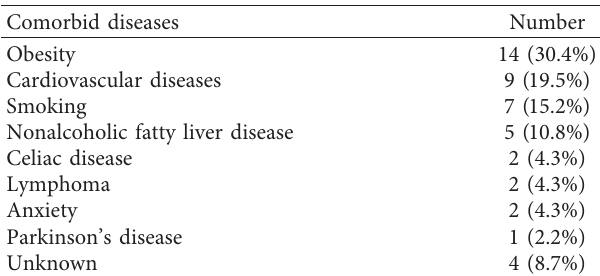
Table 2: Comorbid diseases in psoriatic patients in the present